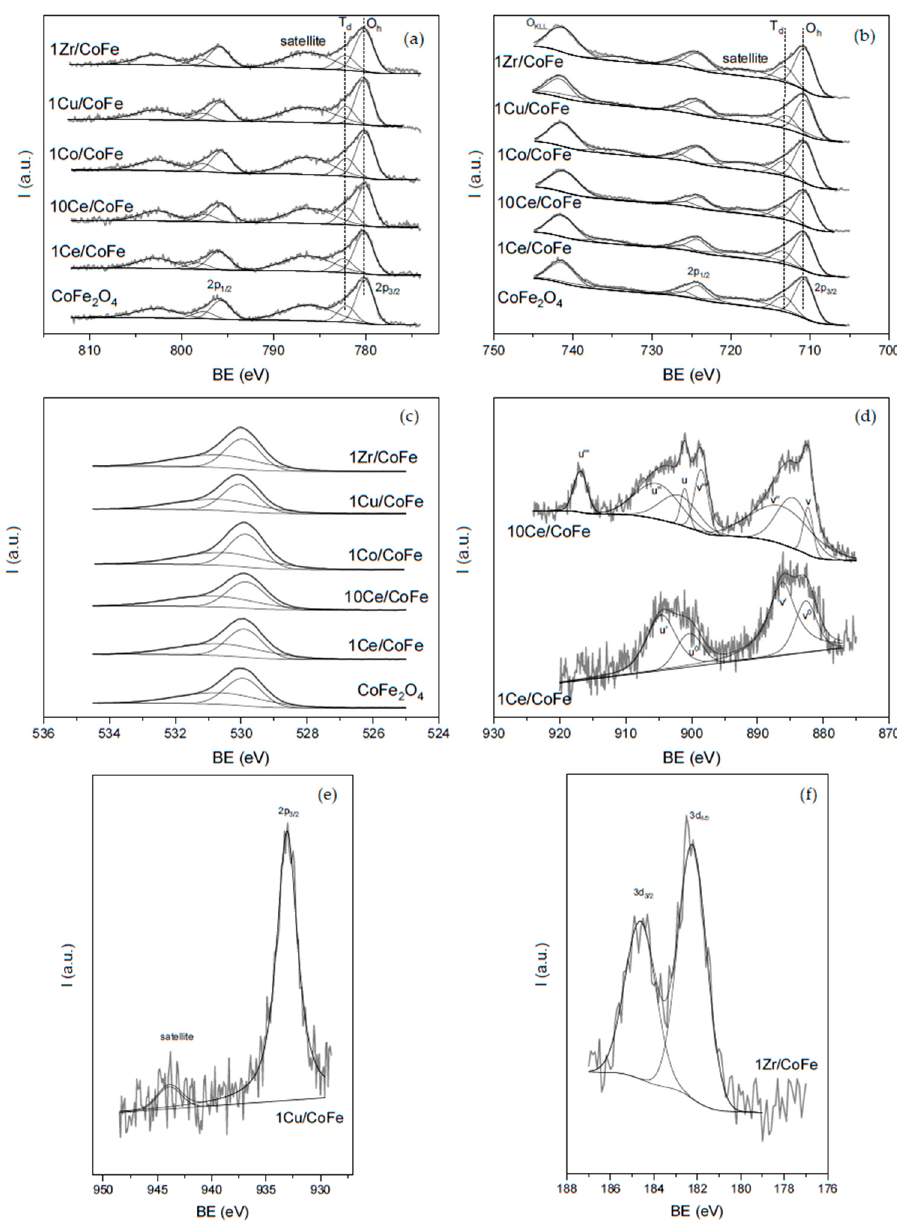
Figure 4. XPS (X-ray photoelectron spectra) for the indicated samples at regions ( a ) Co 2p; ( b ) Fe 2p; ( c ) O 1s; ( d ) Ce 3d; ( e ) Cu 2p 3/2 ; and ( f ) Zr